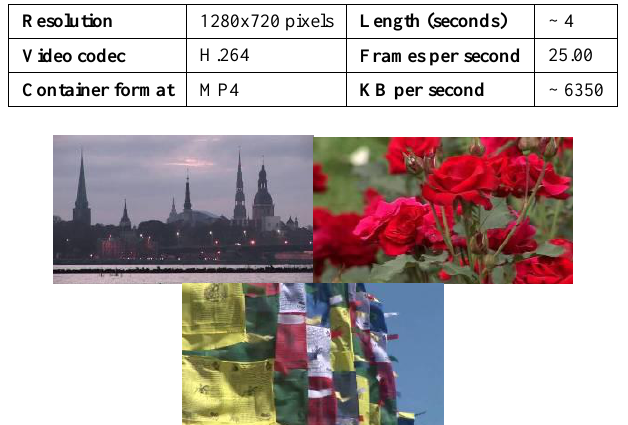
Fig. 4. Frames from the video containers used (riga.mp4, flowers.mp4, flags.mp4).